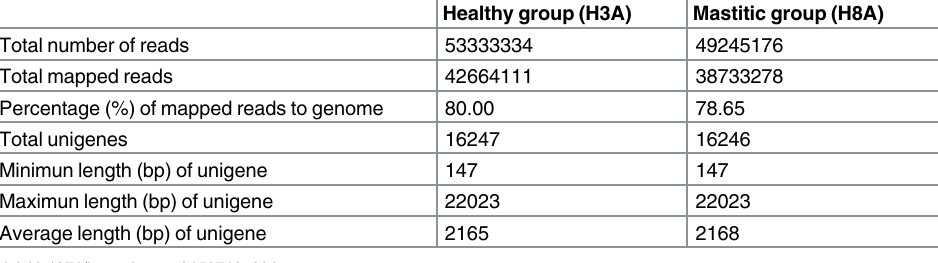
Table 1. Sequencing and assembly results of two